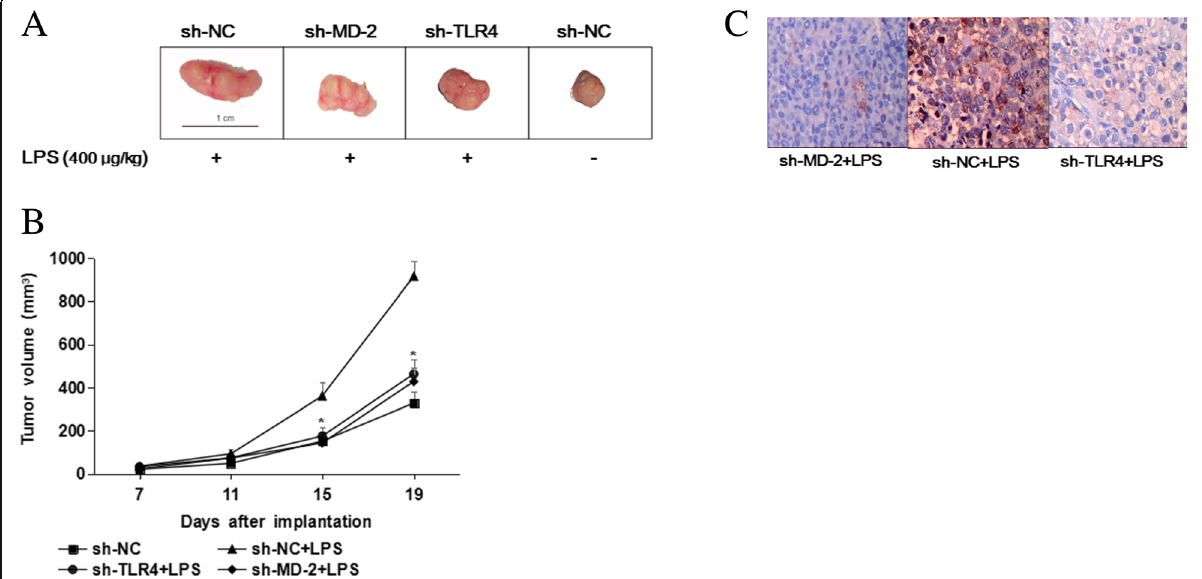
Fig. 5 LPS enhances the tumorigenicity of SGC7901 cells via the TLR4/MD-2 pathway. a and b : SGC7901 cells (2 × 10 6 cells/mice) treated with different shRNAs (sh-NC, sh-TLR4 and sh-MD-2) were injected subcutaneously into the flanks of nude mice, and the mice were intratumorally injected with LPS (400 μ g/kg) every other day. The tumor volume was observed ( a ) and measured ( b ); *, P < 0.05. The data are presented as the mean ± SD; C: CXCR7 expression in tumors was analyzed via immunohistochemistry (original magnification 400×)